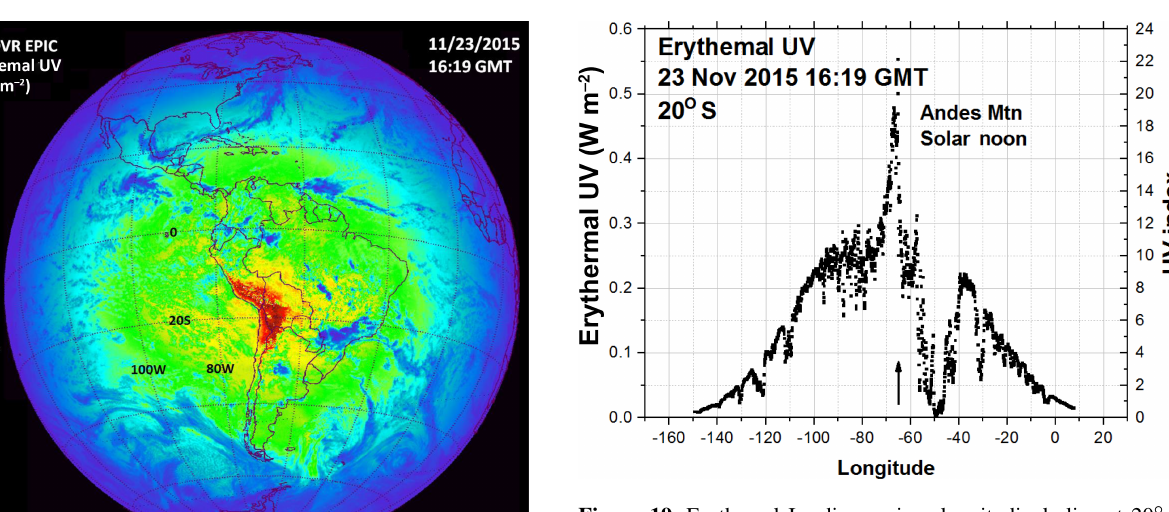
Figure 19. Erythemal Irradiances in a longitudinal slice at 20 ◦ S through a peak occurring in the Andes Mountains. Local noon is at 64.75 ◦ W.